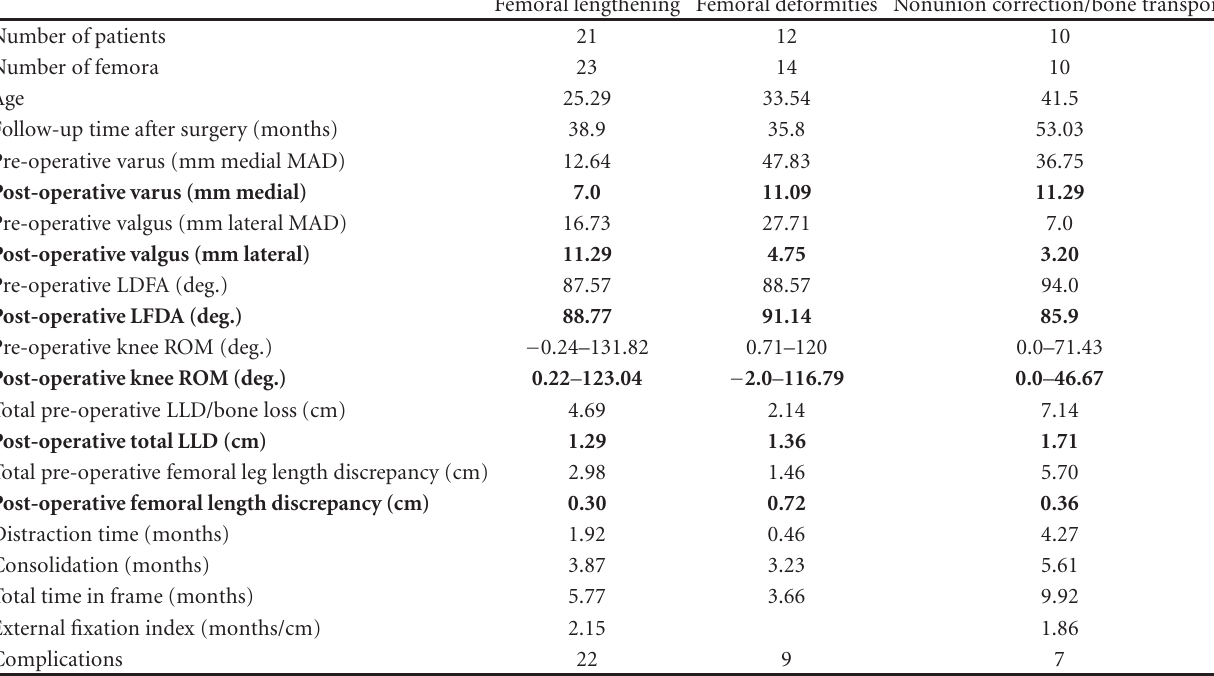
Table 5: Subgroup Comparison